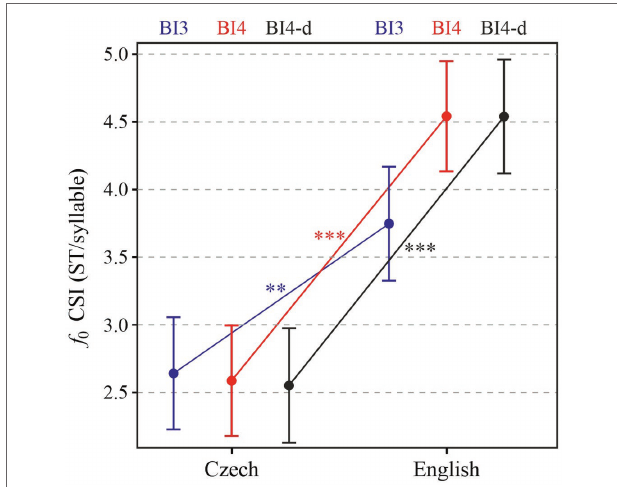
FIGURE 6 | Cumulative slope index (CSI) of f 0 in each prosodic phrase depending on L anguage and P rosodic break type (BI3 in blue, BI4 in red, and BI4-d in black). ** p < 0.05; *** p < 0.001.